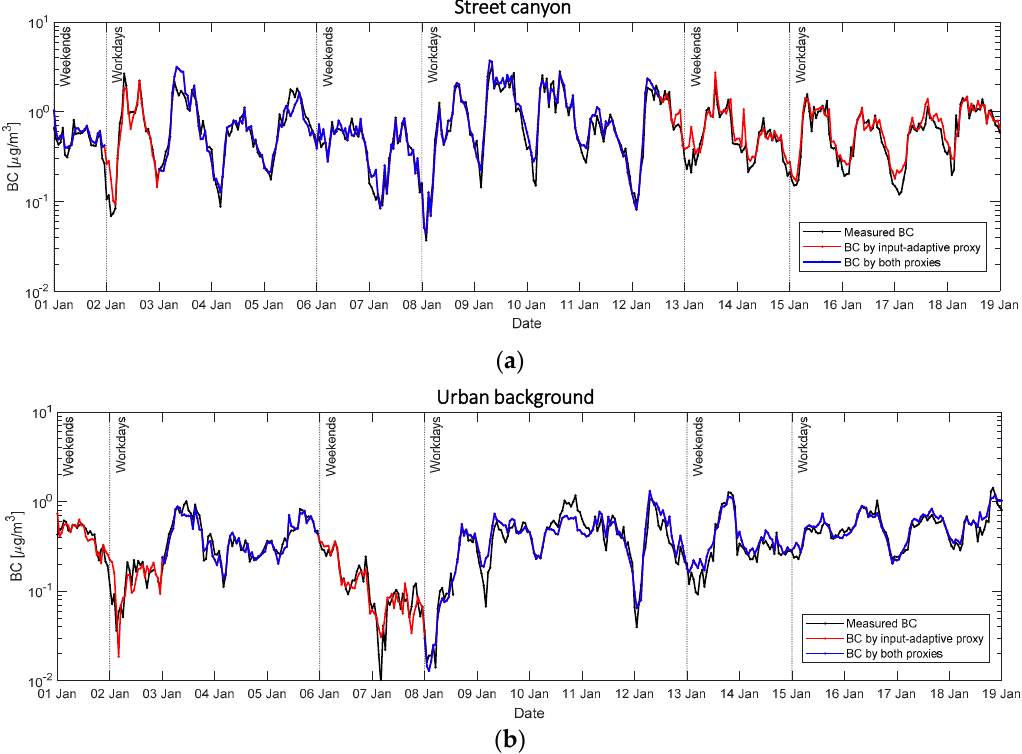
Figure 7. Time series plots in the period from 1 January to 20 January 2018 showing measured BC concentrations in black line. Blue lines represents the calculated BC by the traditional proxy (the input-adaptive proxy with the best performance). Red lines shows the calculated BC by input-adaptive proxy when the estimation could not be made by the traditional proxy. ( a , b ) show data in Mäkelänkatu and Kumpula respectively. Y-axis shows BC concentration in µ g m − 3 shown in logarithmic scale. Workdays and weekends separation are indicated by vertical lines.